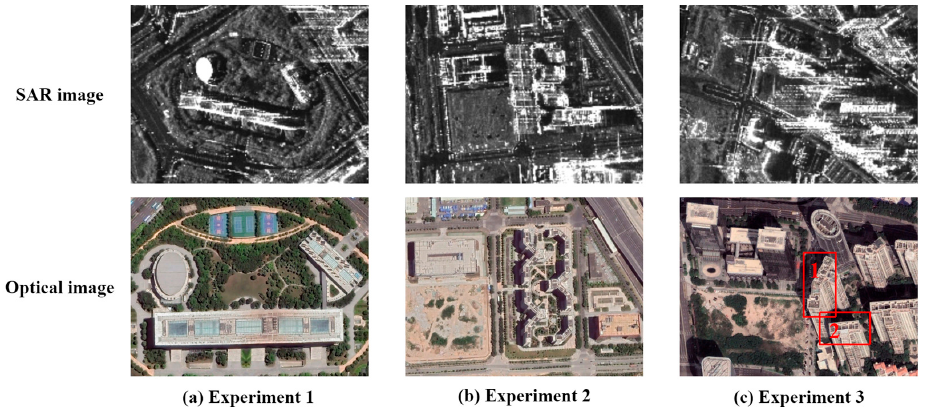
Figure 9. SAR images and optical images of three experimental scenes. The experimental area is red wireframe building 1 and building 2.